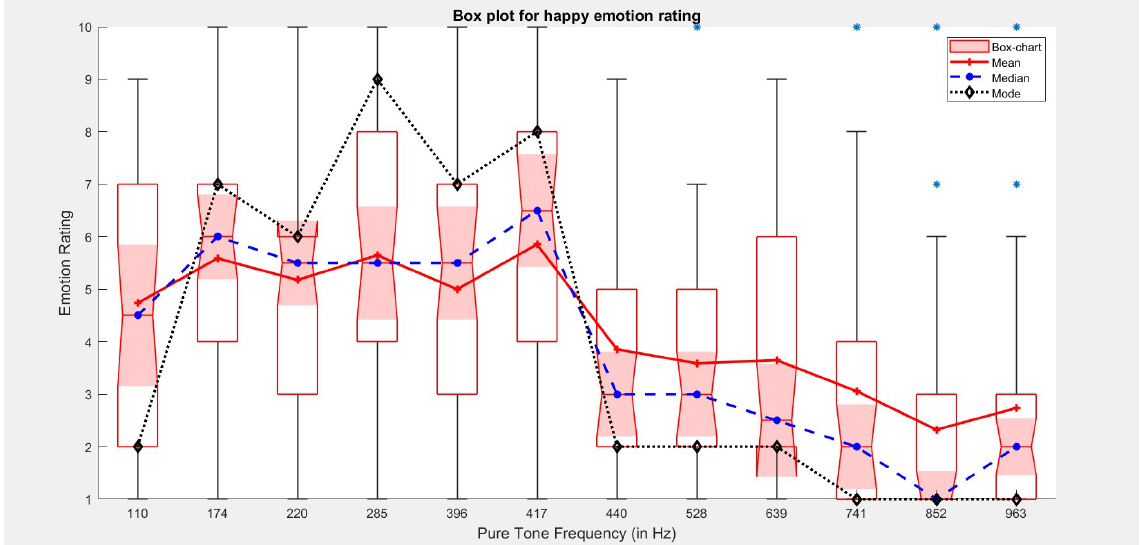
Figure 2. Plot for Happy emotion rating v/s Pure tone frequency. Here, the shaded area (red in color) of box chart represents distribution for annotated emotion corresponding to each pure tone frequency.